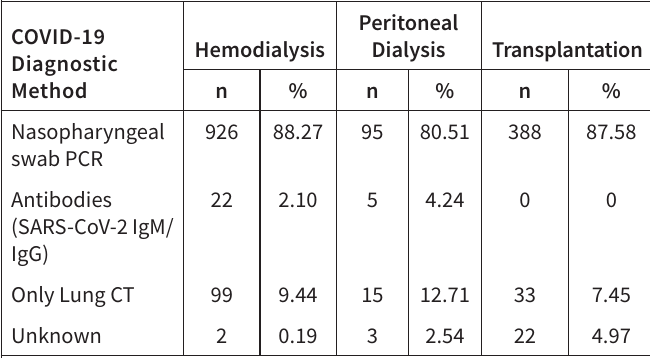
Table 2. Analysis of Coronavirus Disease 2019 Diagnostic Methods in Kidney Replacement Therapy Modalities